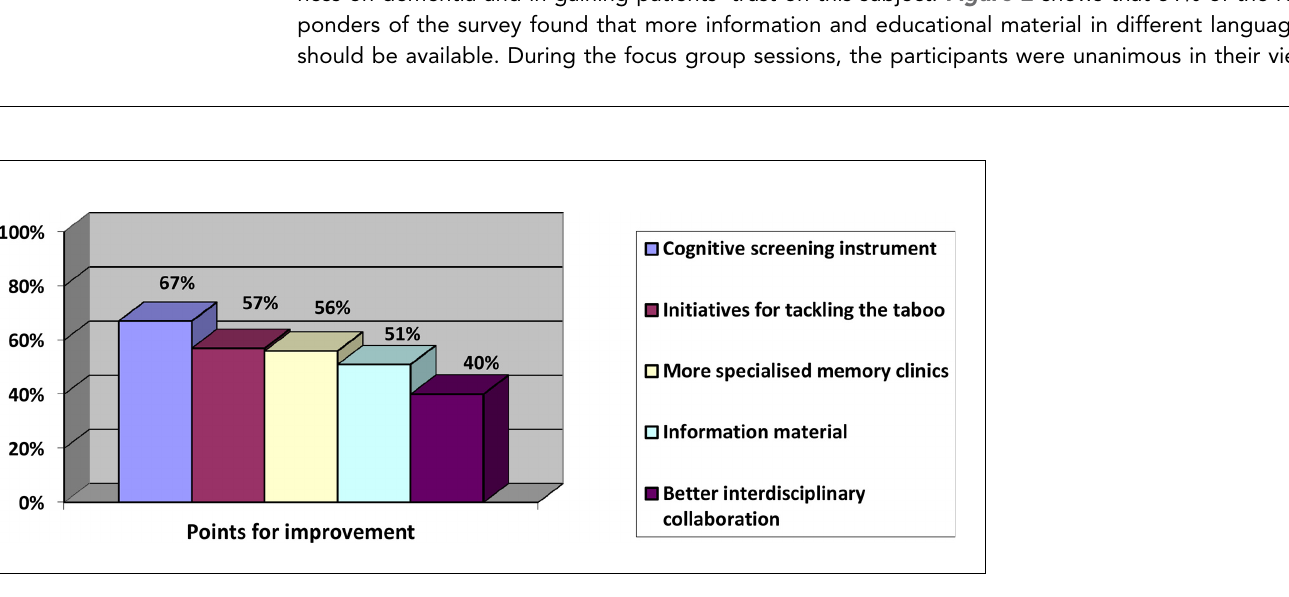
Figure 2. Points for improvement of early signalling of dementia with immigrant